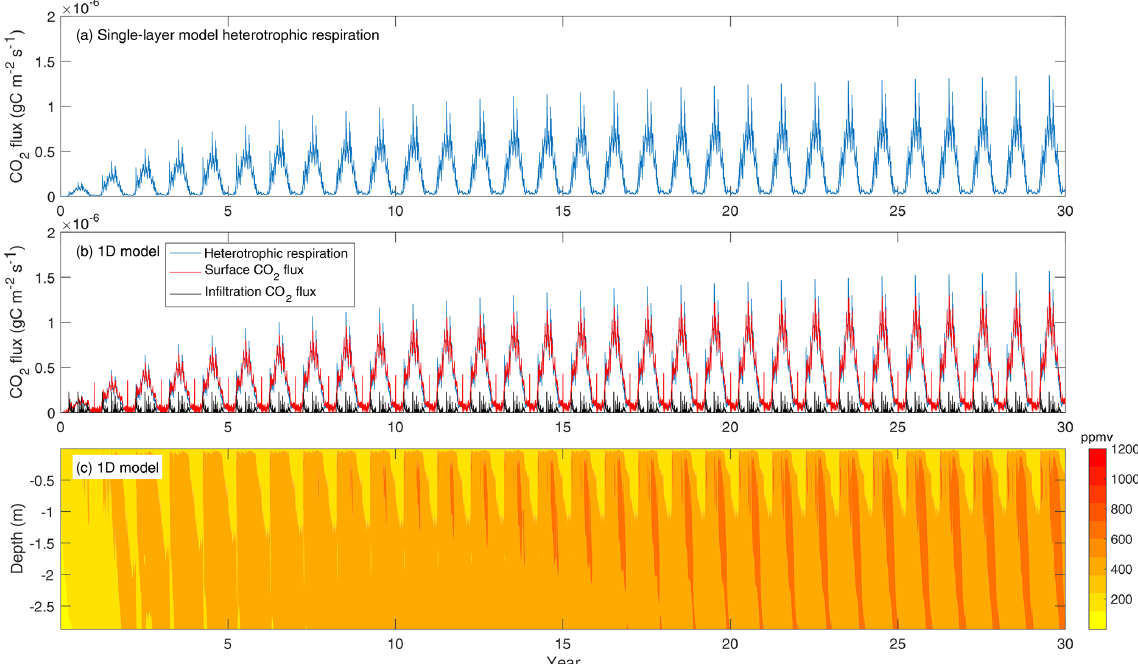
Figure 2. (a) Heterotrophic CO 2 flux simulated by the 10cm thick single-layer model. (b) Column-integrated heterotrophic flux (by summing up contributions from all layers in the soil column), soil surface CO 2 flux (from capillary exchange and diffusion considering equilibrium between gaseous and aqueous phases), and CO 2 infiltration flux. (c) Evolution of soil CO 2 concentration corresponding to panel (b) . The single-layer model used the forcing data for the first layer of the 10-layer